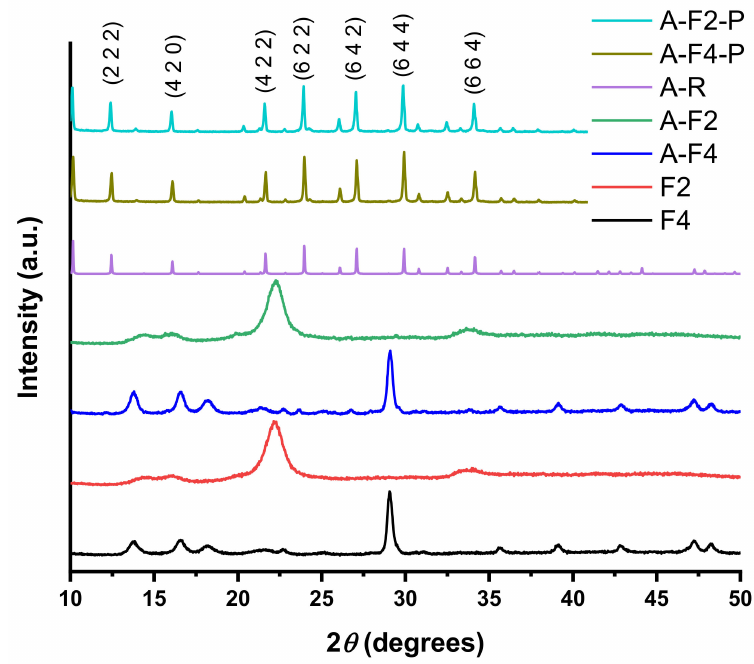
Figure 4. XRD-diffraction patterns corresponding to fabrics and zeolite